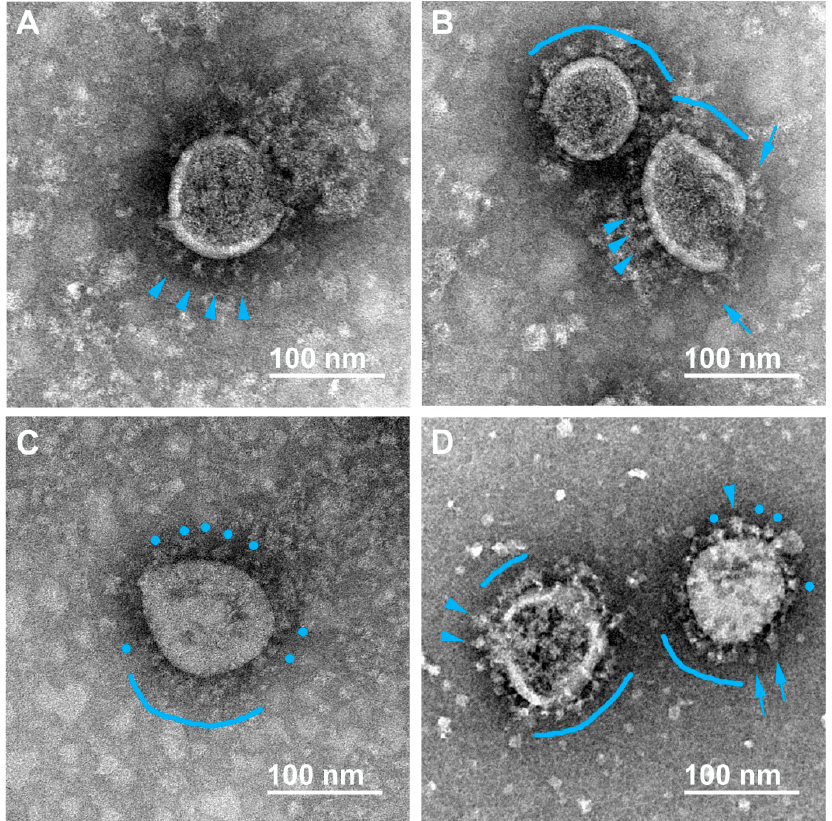
Figure 1. Electron microscopy images of SARS-CoV-2 virions inactivated with 2% formaldehyde (1 h, 37 °C). Various forms of flail-like spikes supposedly corresponding to pre-fusion conformation are observed ( A – D ); single “classical” flails ( A , B , D ) and distorted/rounded flails ( C , D ) are indicated with blue arrowheads and blue circles, respectively. The flail-like spikes essentially tilted to the viral membrane are indicated with blue arrows ( B , D ). Coats of flail-like spikes are marked with blue arches ( B – D ).